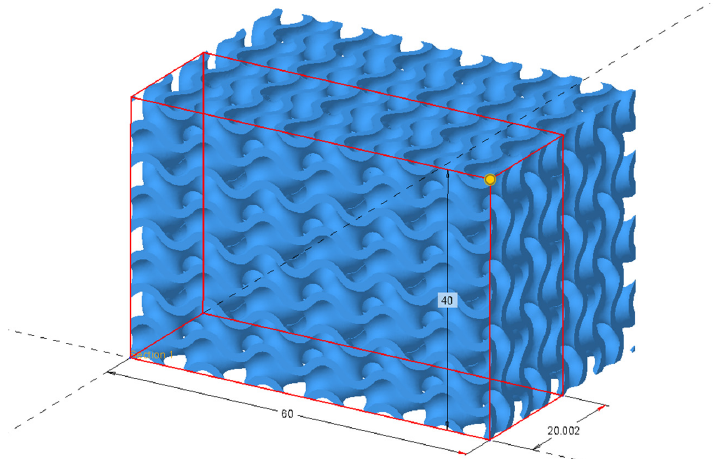
Figure 9. Illustration of the repaired boundary of the basic cellular structure in PTC Creo 9.0.